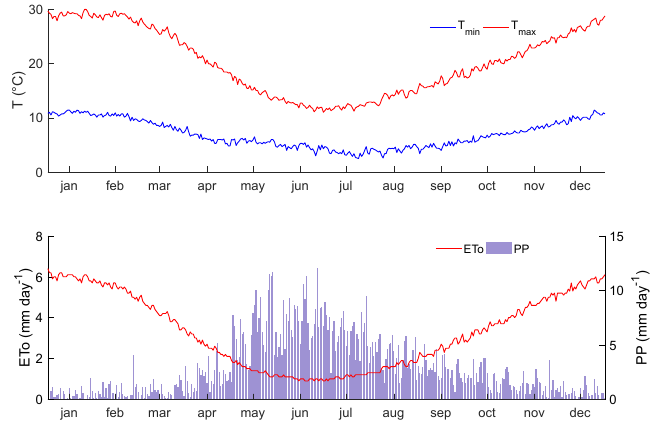
Figure 3. Minimum and maximum temperature ( T min and T max ), reference evapotranspiration ( ETo ), and precipitation ( PP ), as representative of Central Chile [29]. Mean values for the period 1965 to 2016. Values were extracted from the Explorador Climático website (http://explorador.cr2.cl/) and ETo was estimated according to Walter et al. [36]. Table 2. Conservative (constant) and generally applicable parameters for maize, sugar beet, and wheat [20] in the Central Valley of Chile